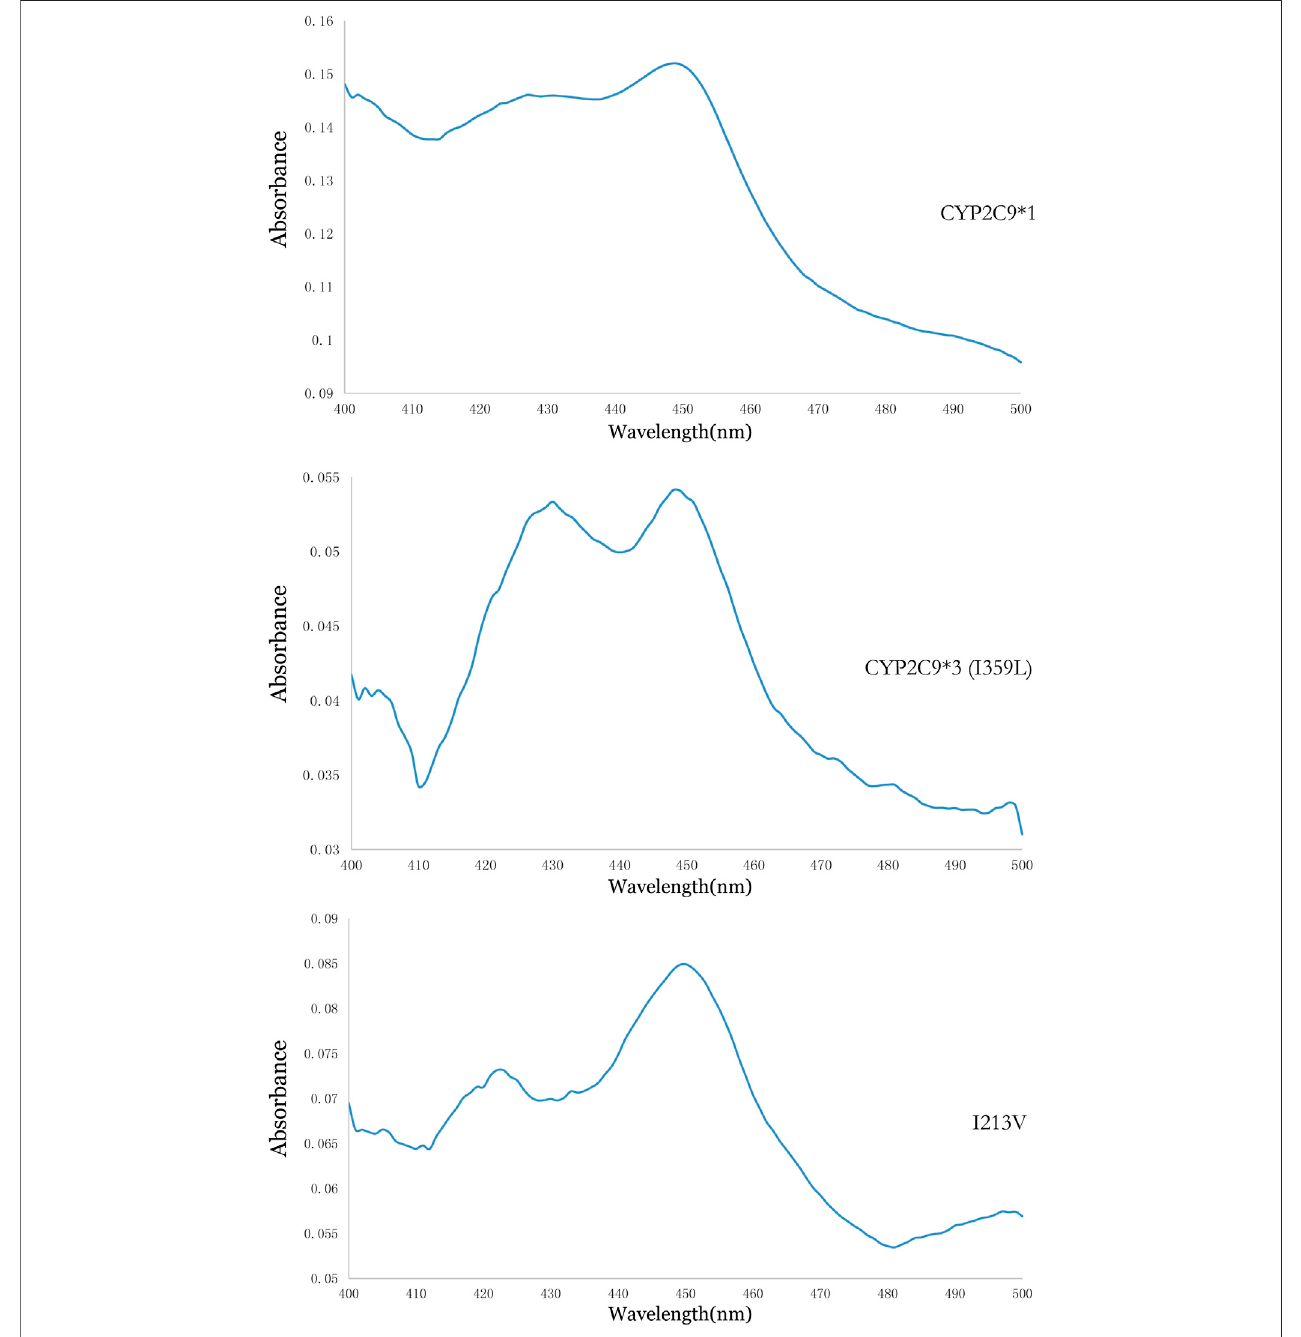
FIGURE 3 | Reduced carbon monoxide difference spectra for the recombinant CYP2C9 in the Sf 21 insect cell microsomes.